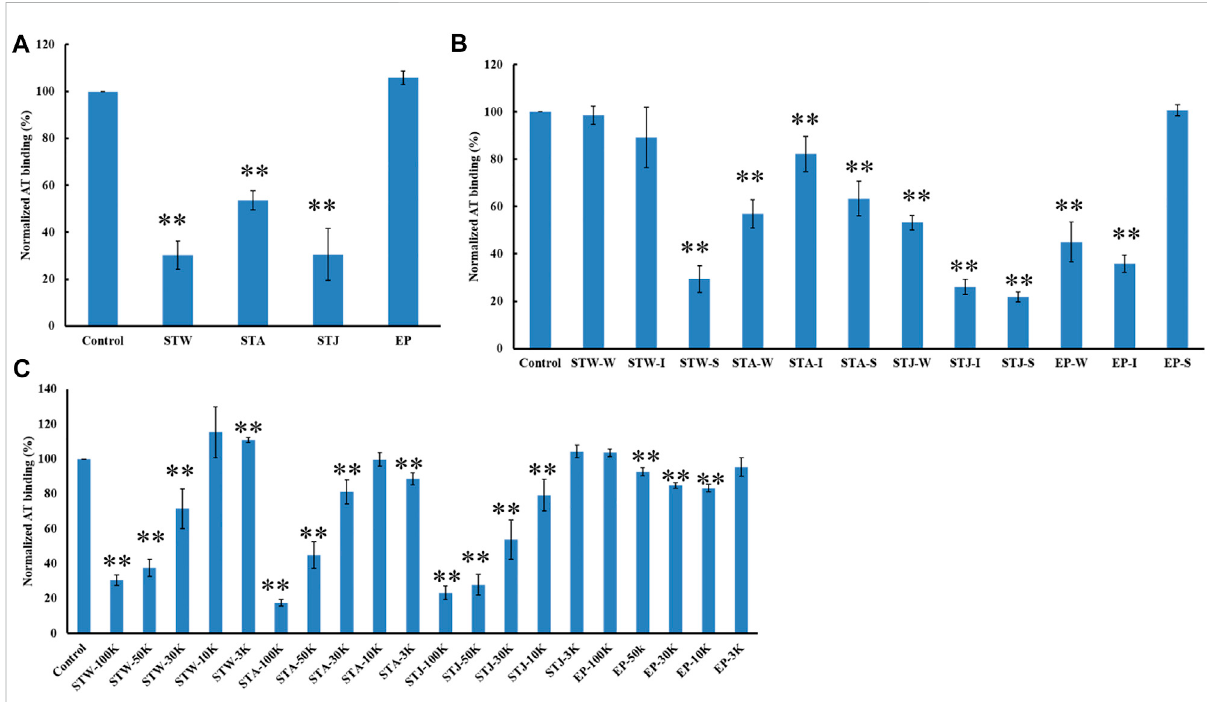
FIGURE 6 ThebindingabilitiesofAT(250 nM)premixedwithdifferentpolysaccharidesonaheparinchip. (A) Crudepolysaccharides; (B) fractionsobtained by anion exchange chromatography; (C) fractionsderived from MWCO membranes. All bar graphs with standard deviations were based on triplicate experiments. * p < 0.05, ** p < 0.01 compared with control.